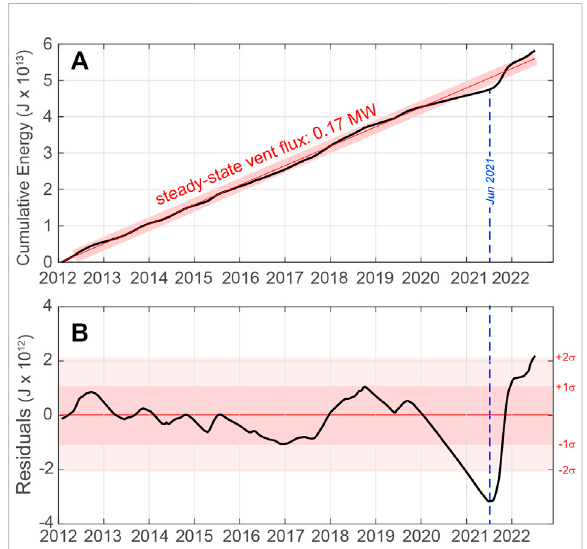
FIGURE 3 (A) Cumulative radiant energy released by the vent fl ux area of La Fossa volcano between 2012 and 2022 (only Suomi-NPP has been considered). The steady-state thermal emission model (red line) indicates a long-term radiant fl ux of ~0.17 MW. (B) Residuals of thermal energy (observed — model) show the departure from the steady-state model (red line with ± 2 σ variations). A clear decrease in the thermal emission was recorded between July 2020 and June 2021 resulting from particularly low thermalemissions.Inthefollowingmonths,La Fossaentersastate of major unrest (still ongoing on 15 July